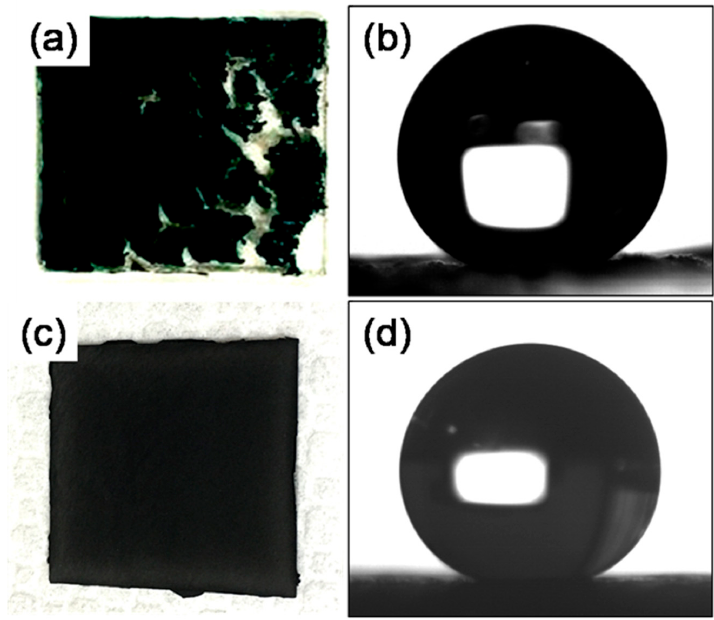
Figure 1. ( a ) Photograph of sample A. ( b ) Profile of a water drop on sample A. ( c ) Photograph of sample B. ( d ) Profile of a water drop on sample B. sample B. ( d ) Profile of a water drop on sample B. Polymers 2018 , 10 , x FOR PEER REVIEW